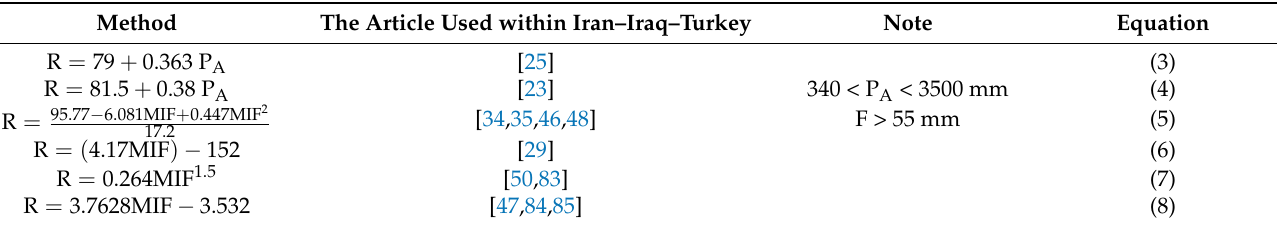
Table 3. Rainfall and runoff erosivity (R) factor models were tested in this